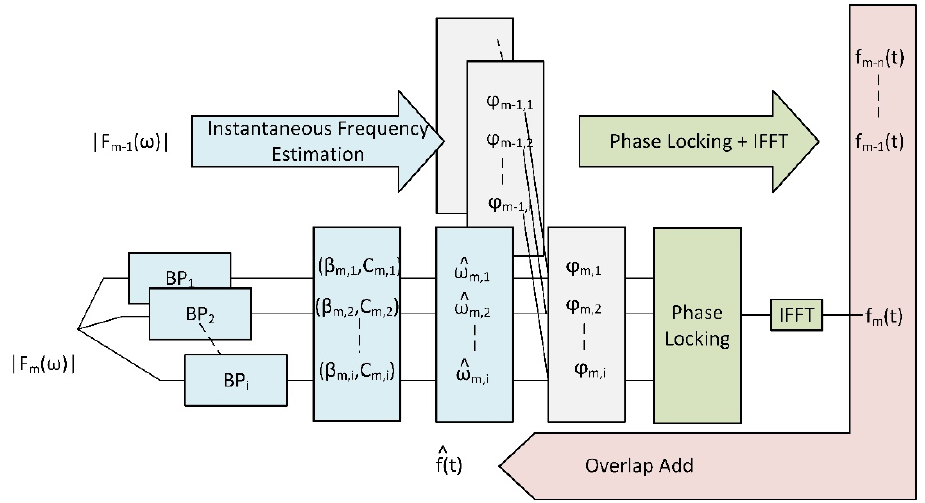
Figure 4. Proposed signal reconstruction flow.